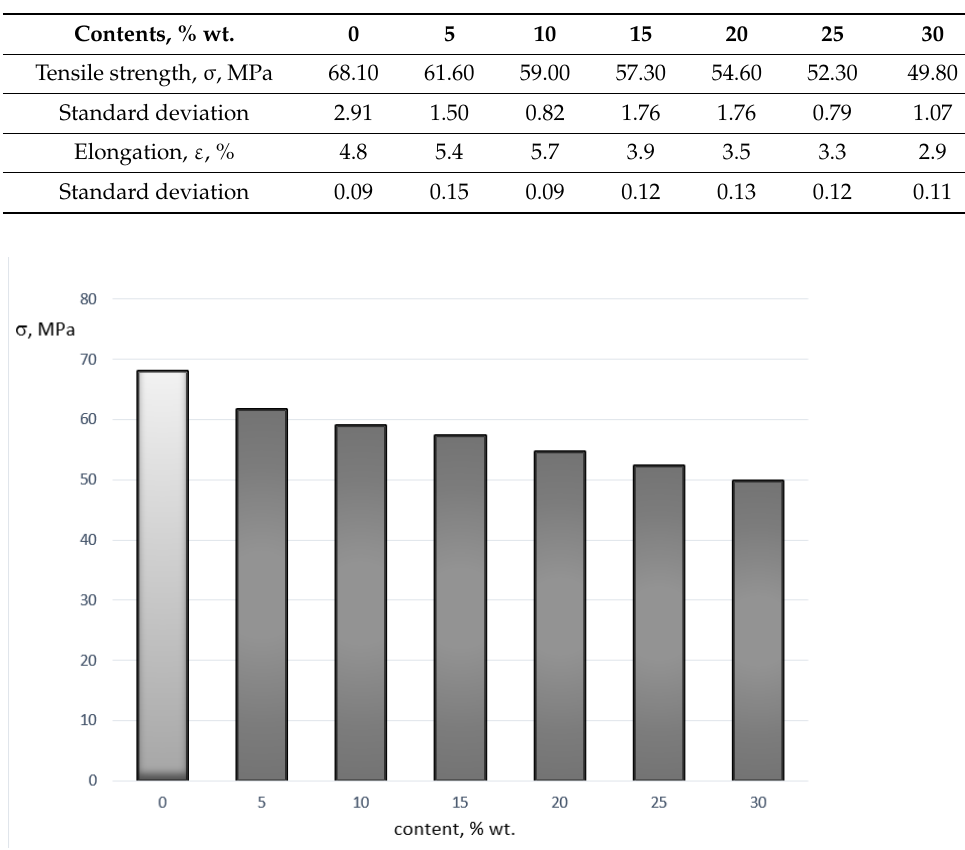
3. Table 7. Impact strength depending on the content of the content of the Crusil M20 filler. Contents, % wt.